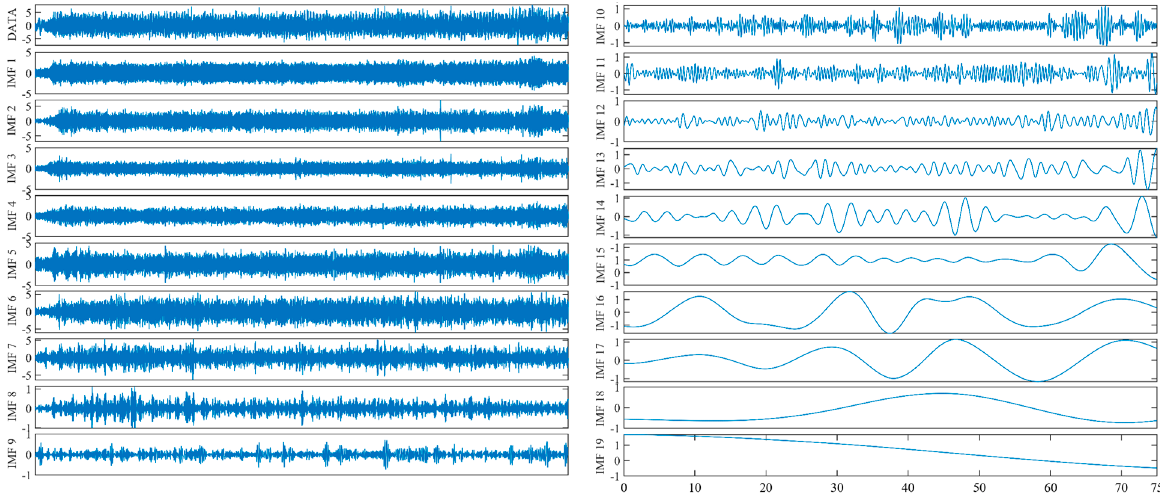
Figure 11. The CEEMDAN decomposition results. Note: X − axis: Time (s), Y − axis: Vibration acceleration (m ꞏ s − 2 ).